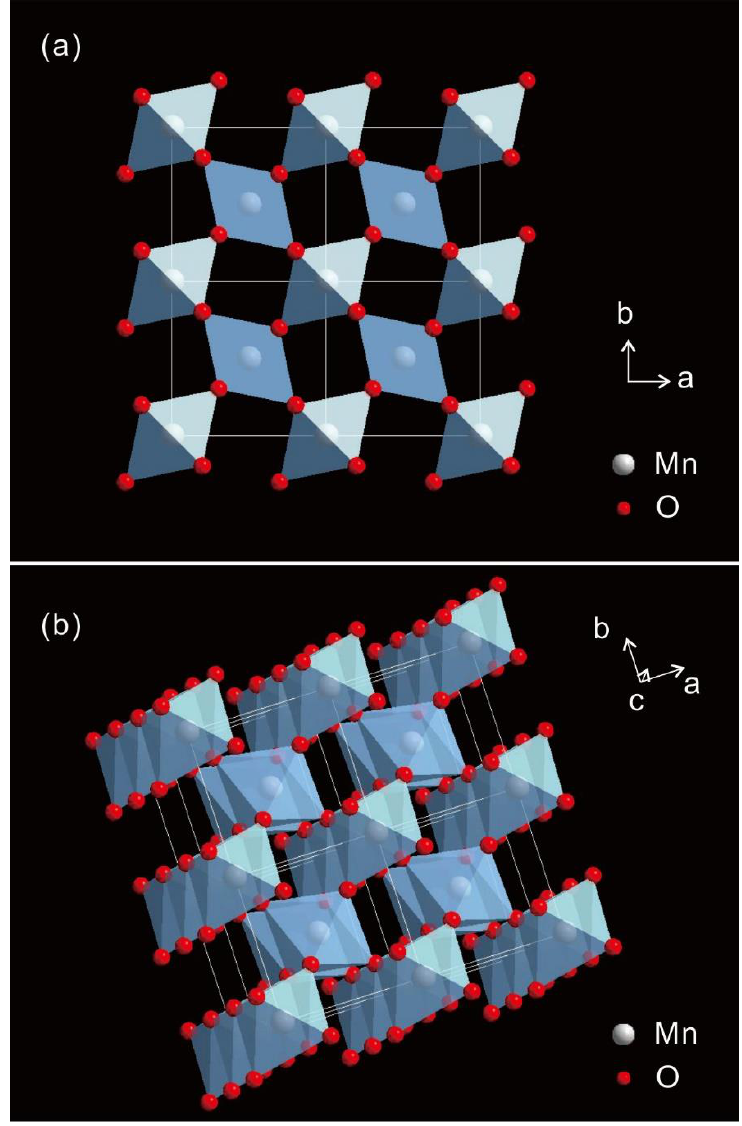
Figure 9. Crystal structure of pyrolusite (based on eight-unit cells) established by using the Diamond crystal modeling software. ( a ) The view perpendicular to c crystallographic axis; ( b ) the view skewed to c crystallographic axis.